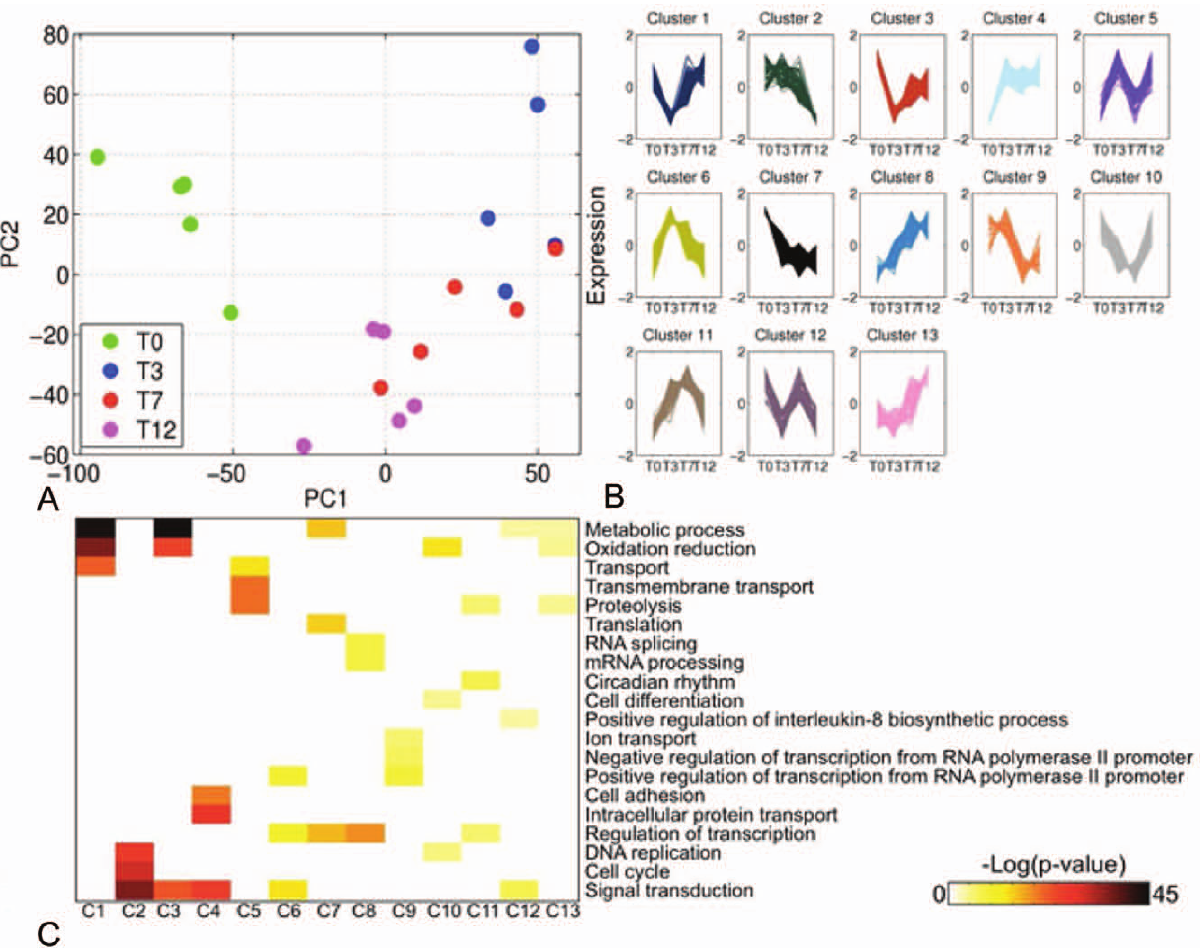
Figure 5. Differential expression analysis of the TNBS transcriptome. (A) Scatter plot of the Principal Component Analysis of 8316 genes in response to TNBS. (B) Expression profiles of genes assigned to the 13 clusters of similar expression (see Table S1). Only differentially expressed genes are included. (C) Heat map visualizing functional enrichment of the 13 clusters for over-represented Gene Ontology Biological Process terms. Darker shades represent a greater degree of